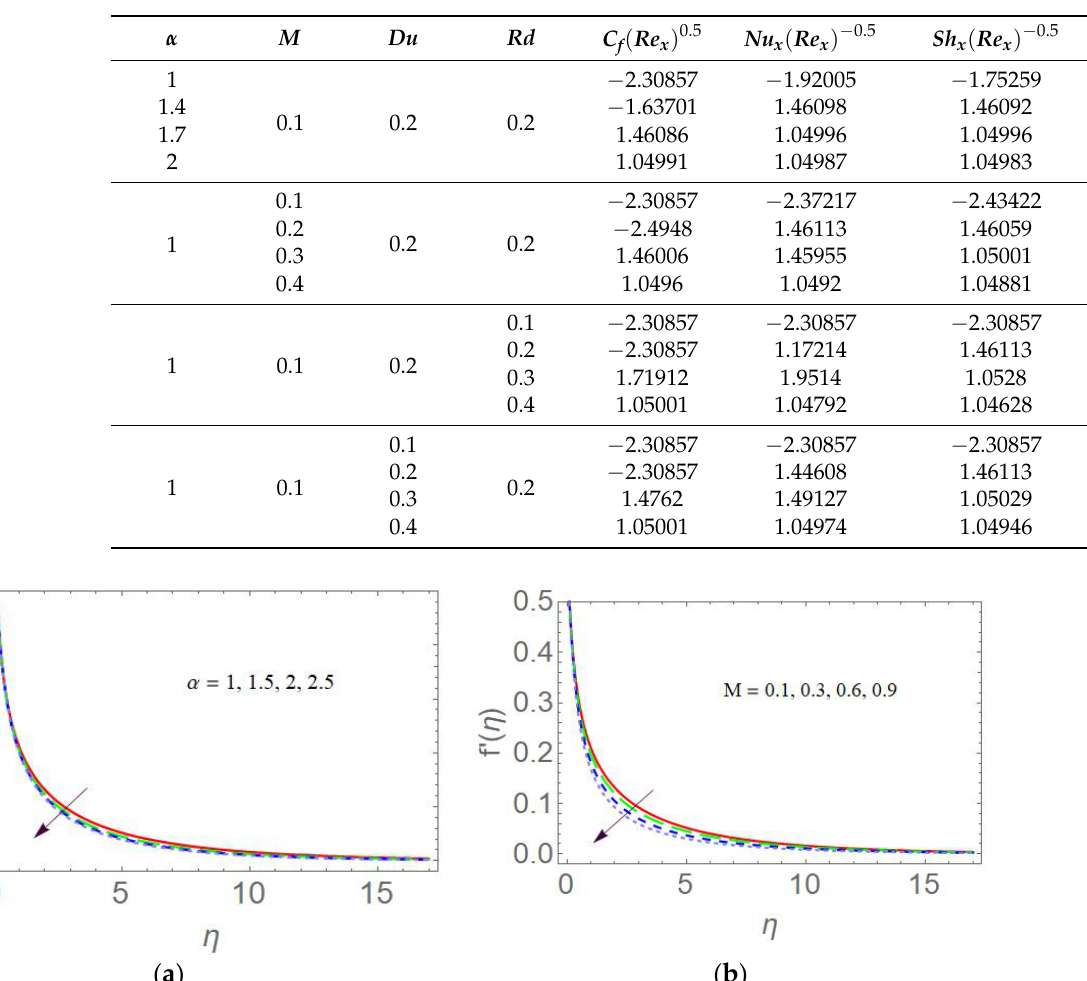
Figure 3. Impacts of ( a ) Casson parameter α on f (cid:48) ( η ) and ( b ) Magnetic parameter M on f (cid:48) ( η ) .